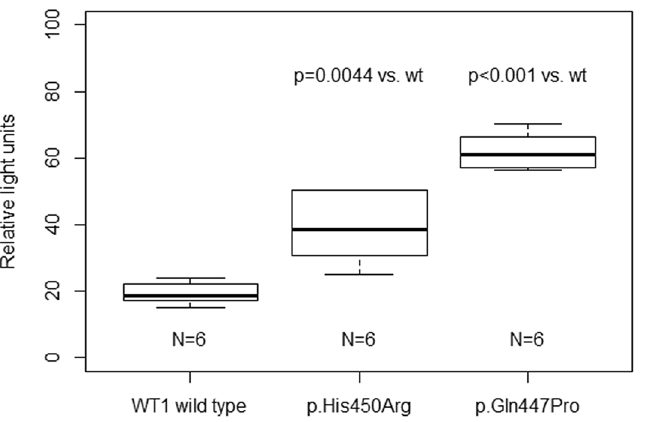
Figure 2. Differential ACTN1 gene expression assessed by luciferase reporter assay. The effect of WT1 protein variants on ACTN1 gene expression assessed by luciferase reporter assay. Both WT1 mutant proteins significantly enhanced ACTN1 expression. The firefly luminescence values were normalized to background (negative control, i.e. vector free HEK293 cells) and to Renilla luminescence to adjust for variance in